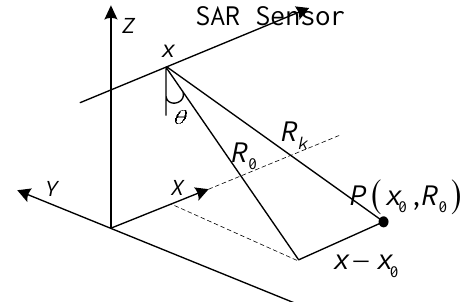
Fig.1. geometrical relationship of SAR sensor and